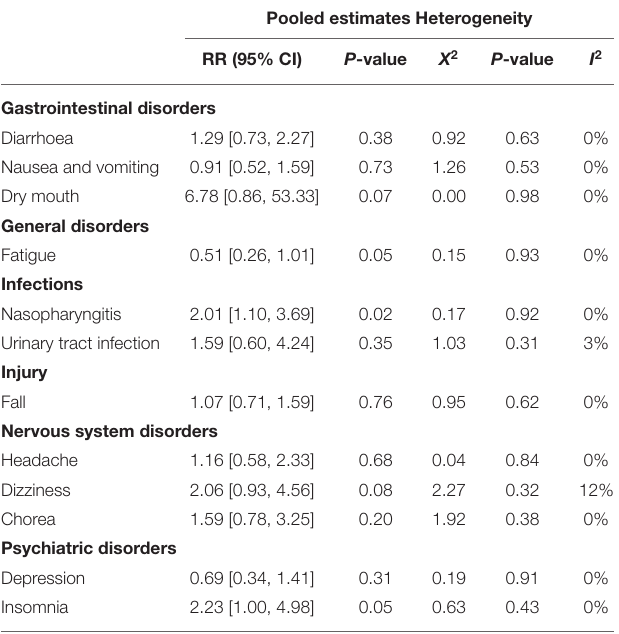
TABLE 2 | Meta-analysis of adverse effects between pridopidine ( ≥ 90 mg/day) and placebo groups.